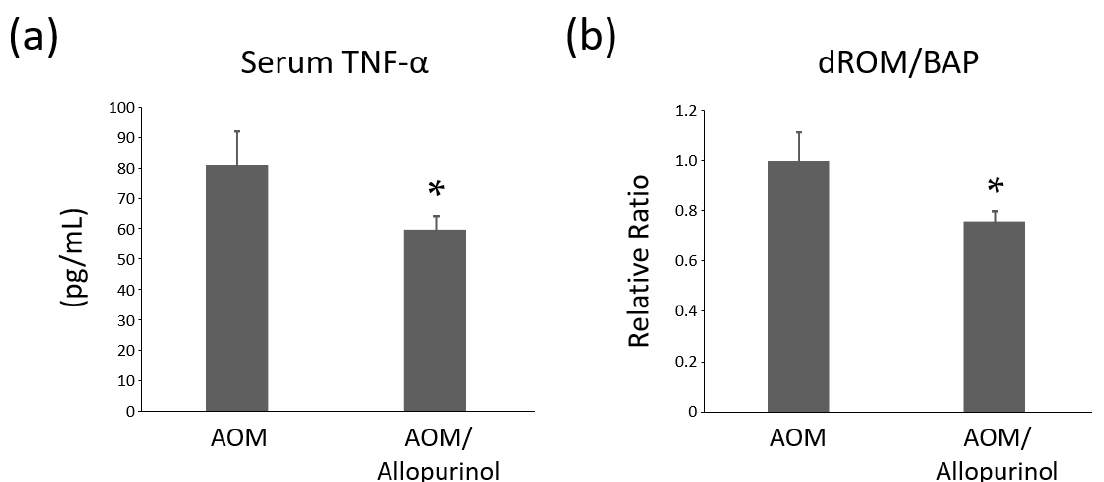
Figure 4. E ff ects of allopurinol on serum TNF- α levels and oxidative stress in the experimental mice. ( a ) Serum concentrations of TNF- α were determined by ELISA. ( b ) Serum levels of derivatives of reactive oxygen metabolite (d-ROM) and biological antioxidant potential (BAP) were evaluated and the ratio was compared as a relative value. Each column represents the mean ± SD. The asterisk (*) indicates the statistically significant di ff erence compared to azoxymethane (AOM)-treated group; p <